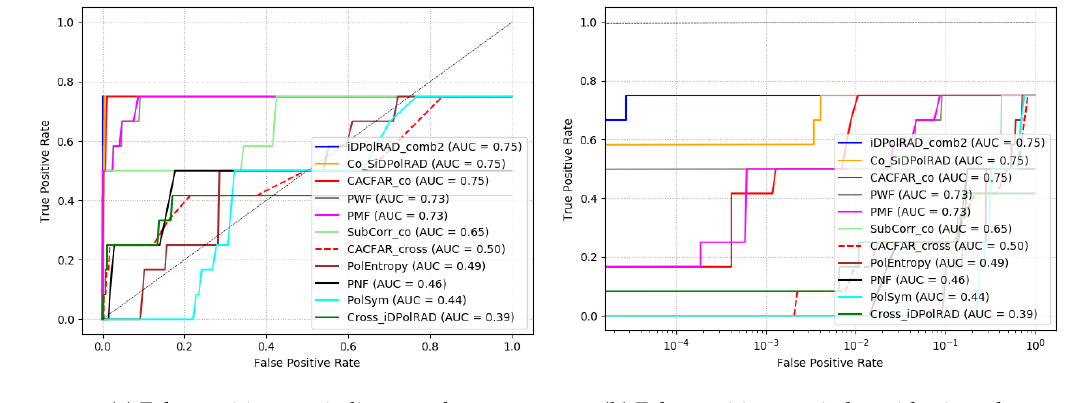
Figure 13. VDS performance test on S1 data (pixel-based,